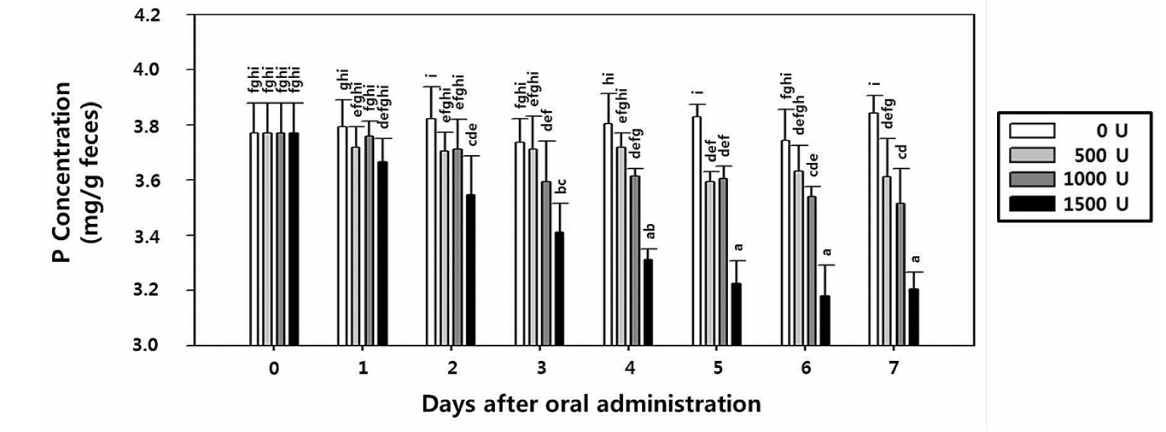
Figure 8. Fecal phosphorus (P) concentration in rats orally administered rPhy-P for seven days. Extractable P was extracted from 1 g feces using Mehlich III solution and determined by ascorbic acid colorimetry. Each value represents the mean ± SE ( n = 3). Different letters indicate significant differences ( p <